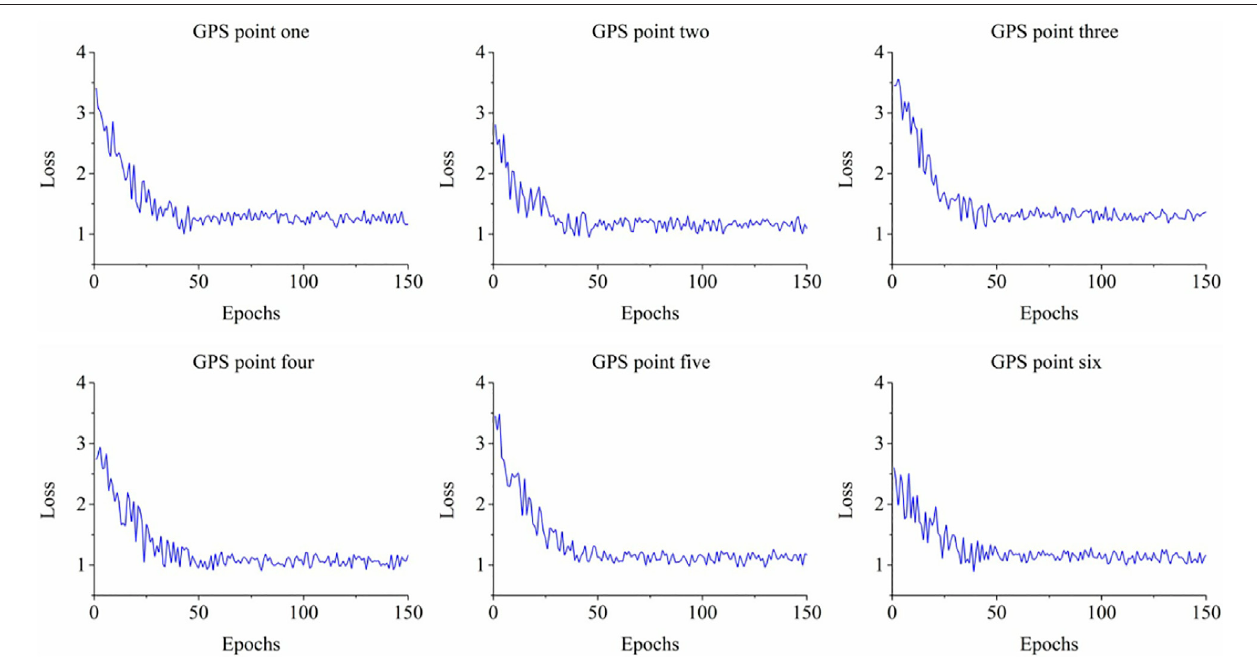
FIGURE 2 | Convergence curves of loss functions during the training process.